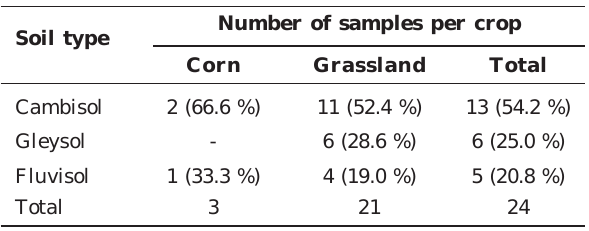
Table 2. Distribution of crops per soil Soil type